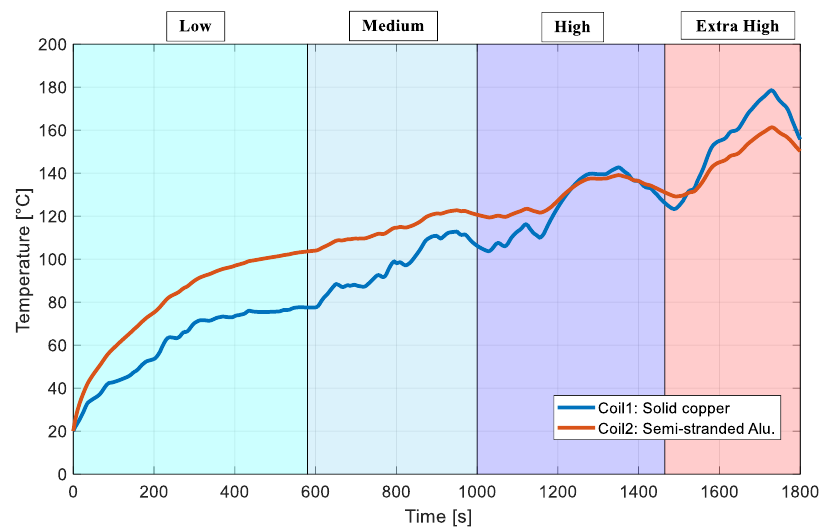
Figure 7. Comparison between the maximum temperature under the same driving cycle (WLTC).